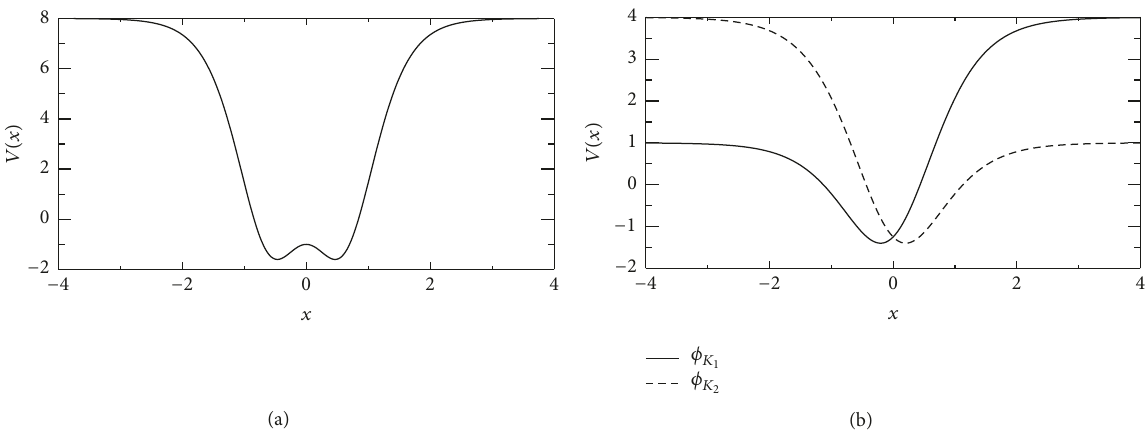
Figure 3: Scattering potentials for the quantum fluctuations in the 𝜙 6 model. (a) Typical example for 𝑎 ̸= 0 ; (b) the case 𝑎 = 0 with the two potentials generated by 𝜙 퐾 (full line) and 𝜙 퐾 (dashed 1 2